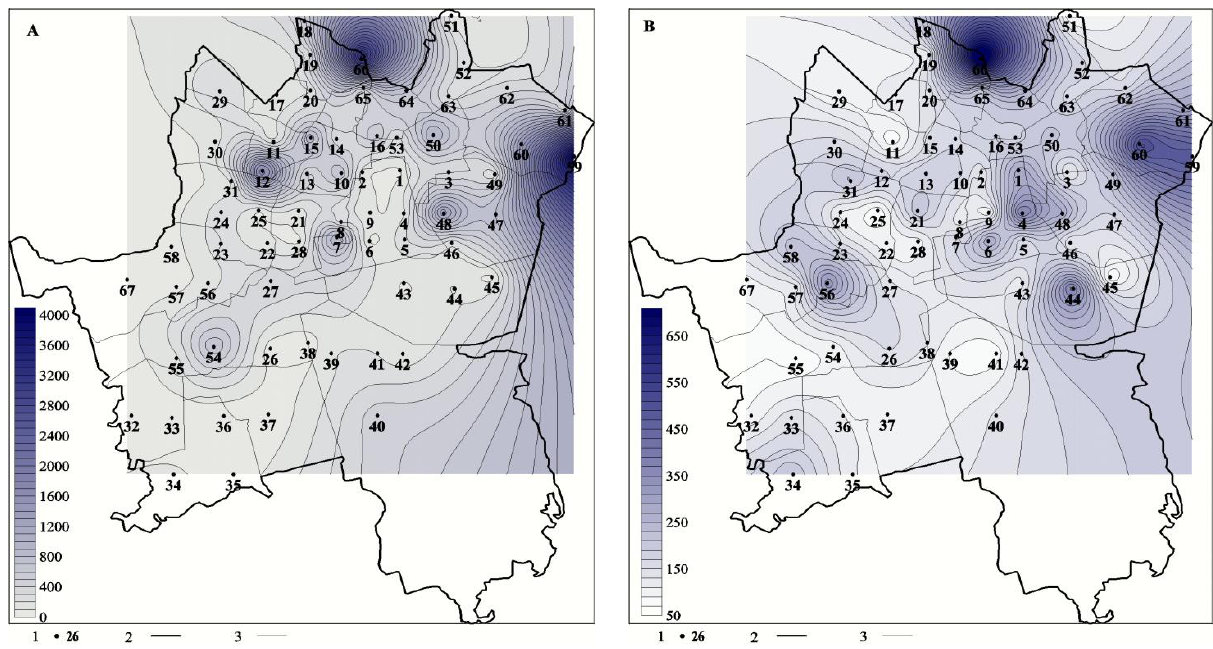
Fig. 3 A, B. Distribution of zinc: A. in soil [mg kg -1 ] and B. in T. officinale Web. leaves [µg g -1 ] within the city of Katowice. 1 – collection points; 2 – the city boundaries; 3 – boundaries of districts